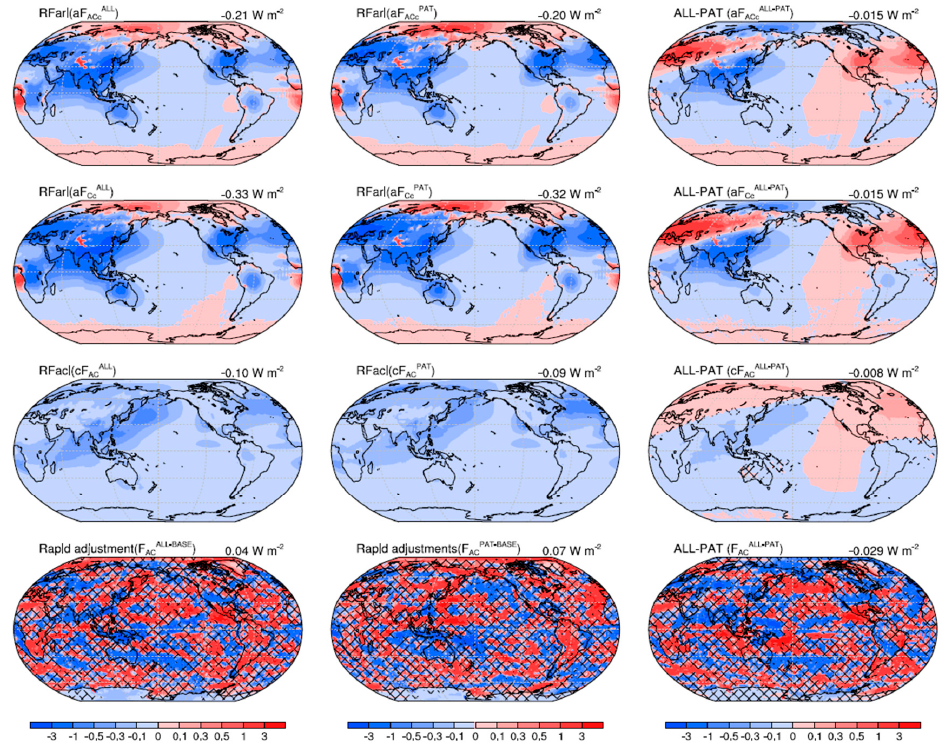
Figure 8. Annual mean maps for the three basic components of anthropogenic aerosol effective radiative forcings, i.e., the instantaneous direct radiative effect (RFari, aFACc and aFCc; top two rows), instantaneous Twomey effect (RFaci; third row), and rapid adjustment (bottom row) with anthropogenic aerosol data for 2000 ( left ), 1975 ( middle ), and their difference ( right ). The global average is given in the upper-right corner. Hatching represents the nonsignificant area at the 90% confidence level of Student’s t -test.